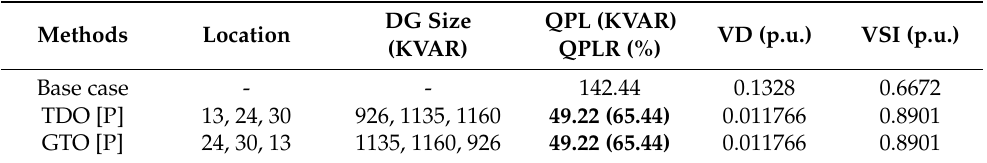
Table A1. Results of OADG for a 33-bus RDN for SOF (QPL minimization) at unity pf (PV type) in a CP load